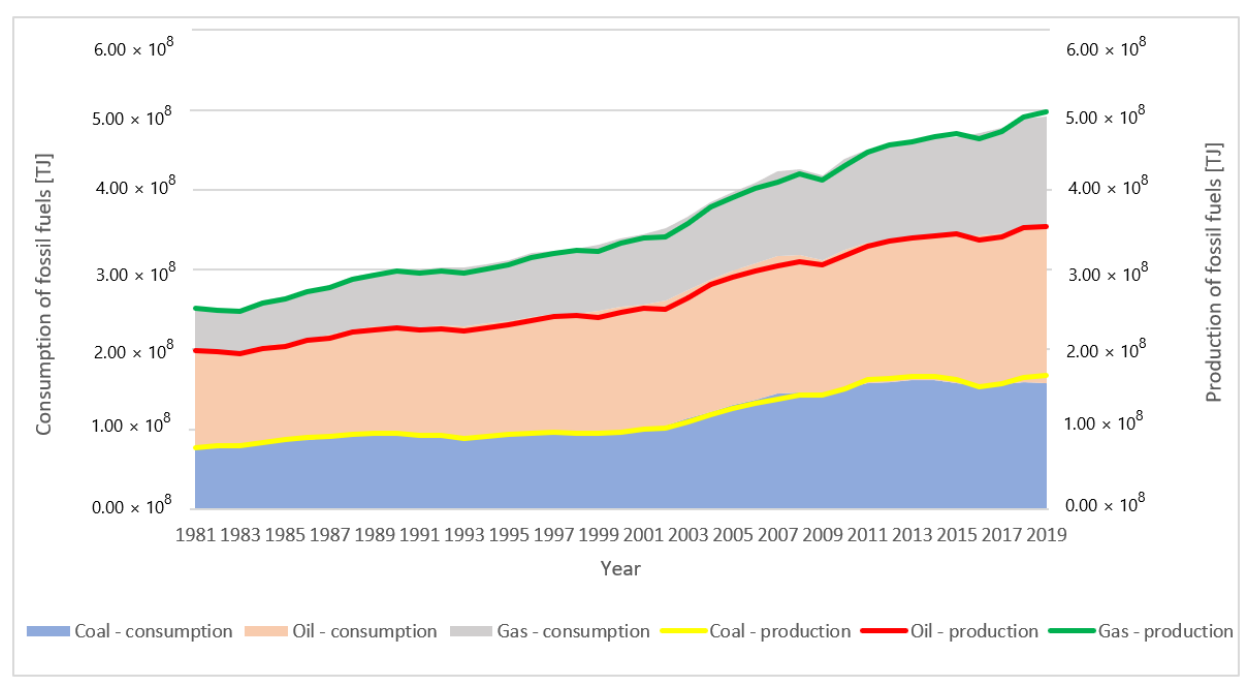
Figure 1. Comparison of fossil fuel production and consumption worldwide.